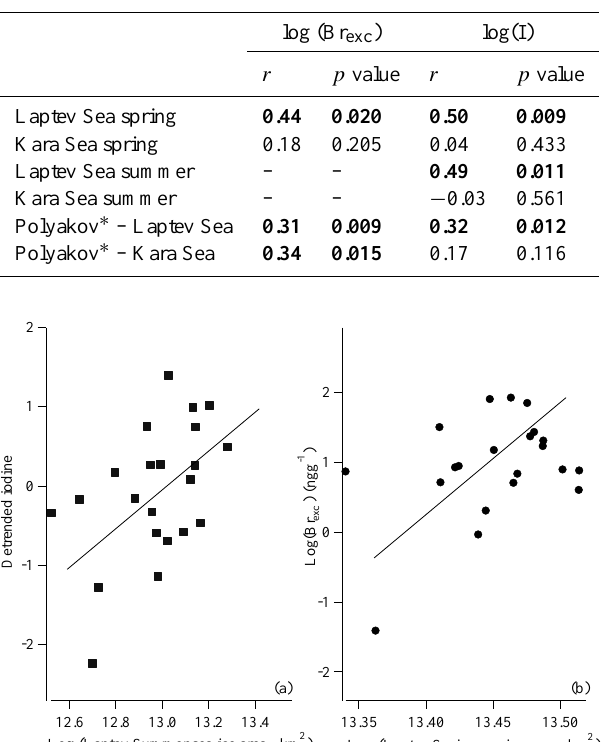
Table 1. Correlations ( r ) of the detrended log(I) and log(Br exc ) with the logarithm of the first-year sea ice area in the Laptev and Kara seas for the period 1979–1999 and the Polyakov anomalies in the Laptev and Kara seas for the period 1950–1999 (denoted by an as- terisk) (Polyakov et al., 2003). Columns display the r values and p values. Bold numbers indicate the statistically significant corre- lations. No correlation has been calculated between log(Brexc) and summer sea ice since the bromine explosion occurs during spring- time.